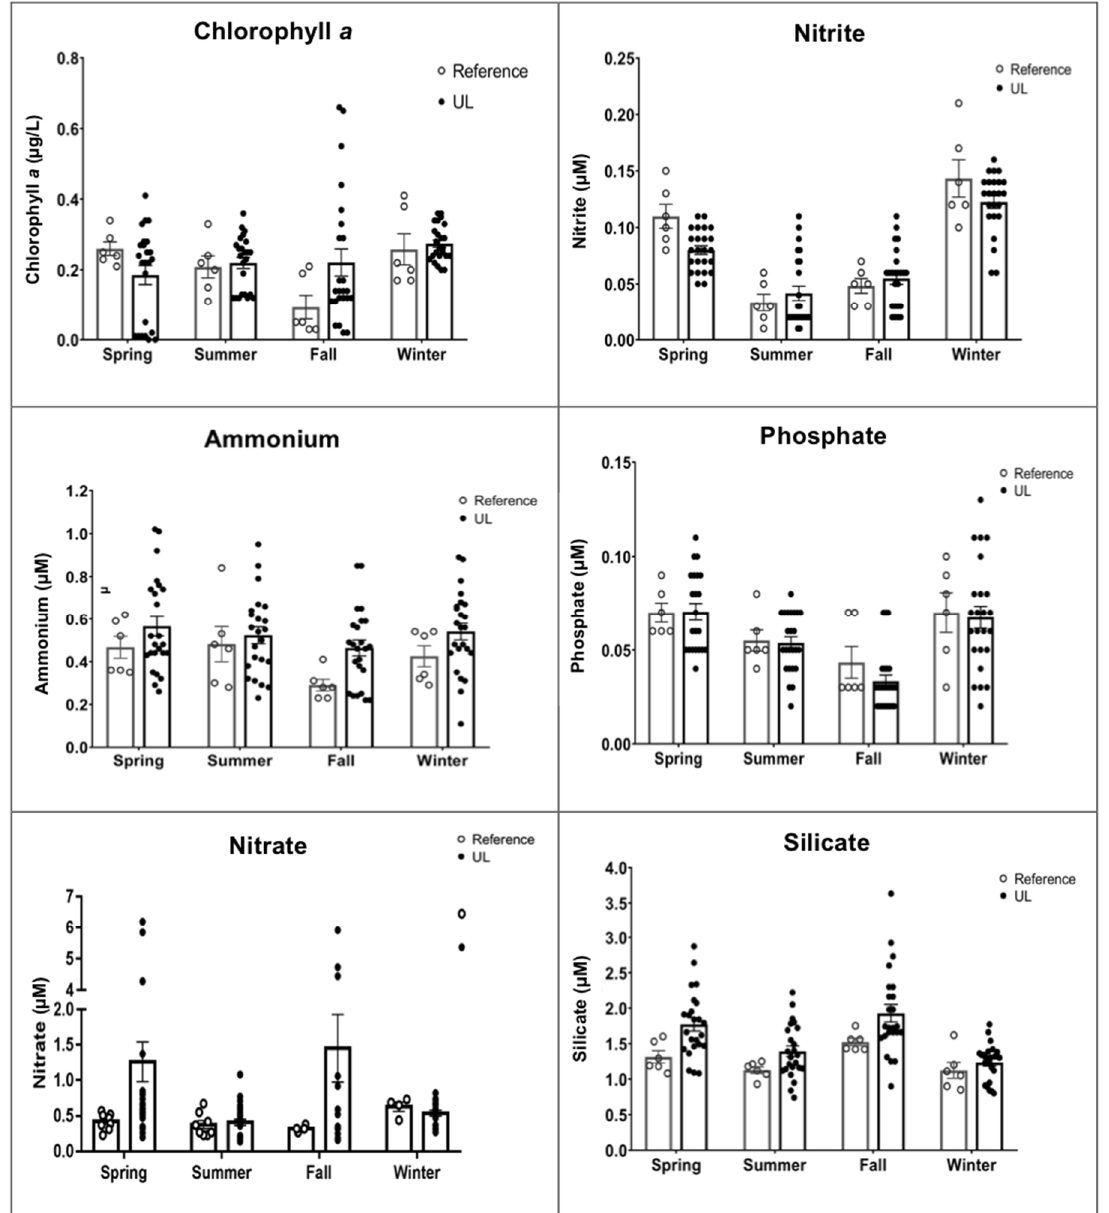
Figure 3. Seasonal water quality parameters as measured in Ayla’s upper lagoon (UL) and the offshore reference stations of the Gulf of Aqaba (GoA). Seasonal average concentrations of Chl a (µg/L), ammonium (NH 4 -N; µM), nitrate (NO 3 -N; µM), nitrite (NO 2 ; µM), phosphate (PO 4 -P; µM), and silicate (SiO 2 ; µM) were measured between July 2012 and June 2013. UL shows significant Chl a heterogeneity between seasons, while the reference stations (ambient seawater conditions) show significant differences between seasons.